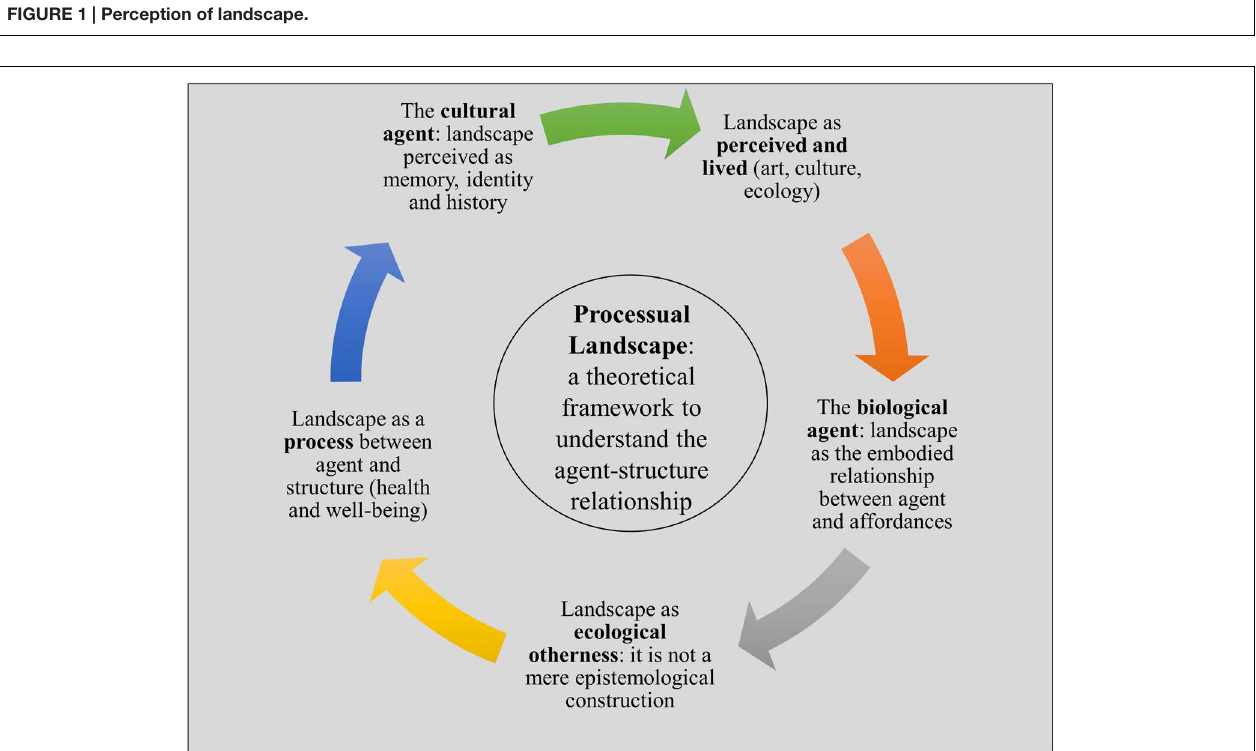
FIGURE 2 | Processual